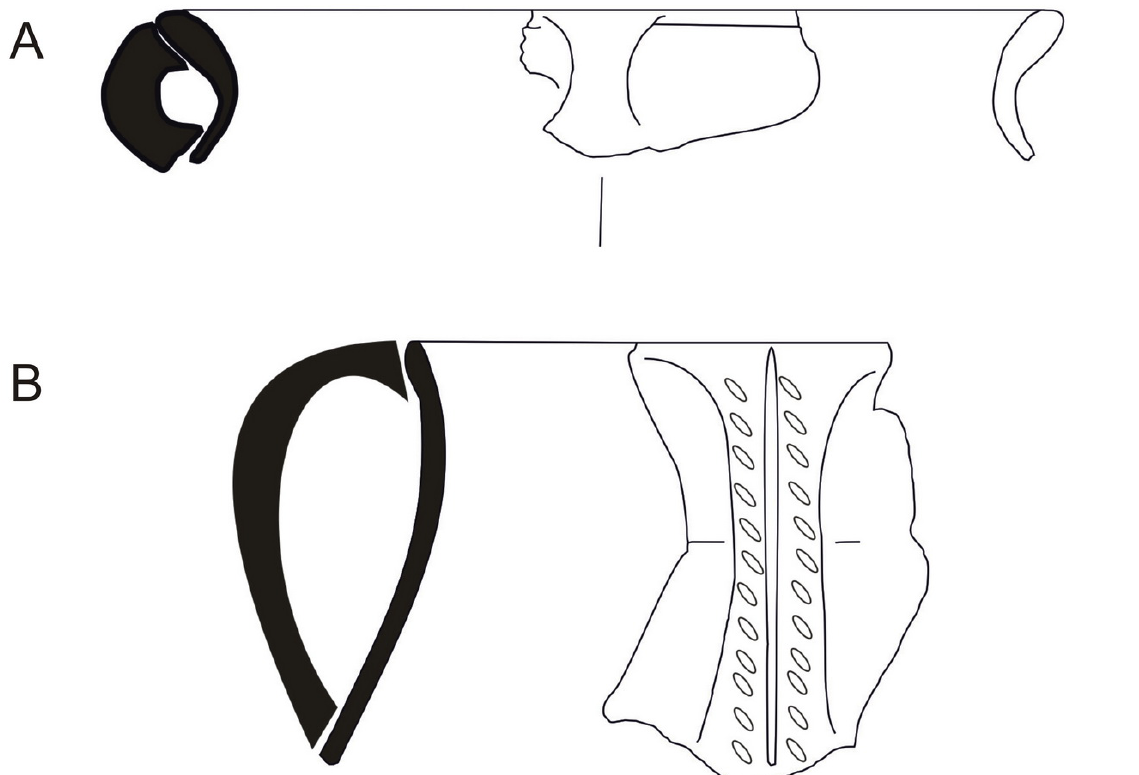
Figure 2. Two examples of from the Second phase of the Galician Iron Age found in the shell-midden (A); A. Toralla-type pot; B. Toralla-type jar.